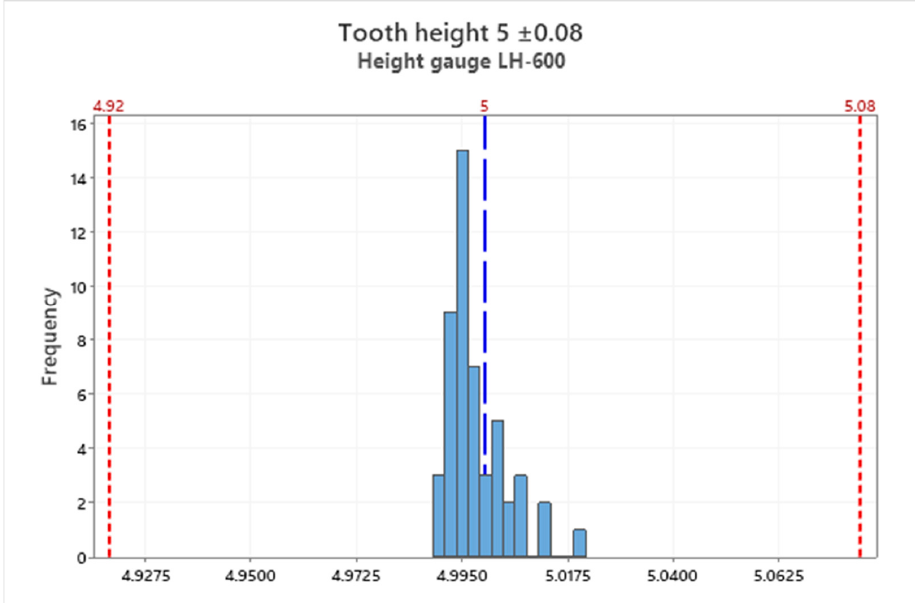
Figure 11. Tooth height 5 ± 0.08 mm—histogram from measurements obtained with the LH-600 height gauge, values on x axis given in mm (own study).